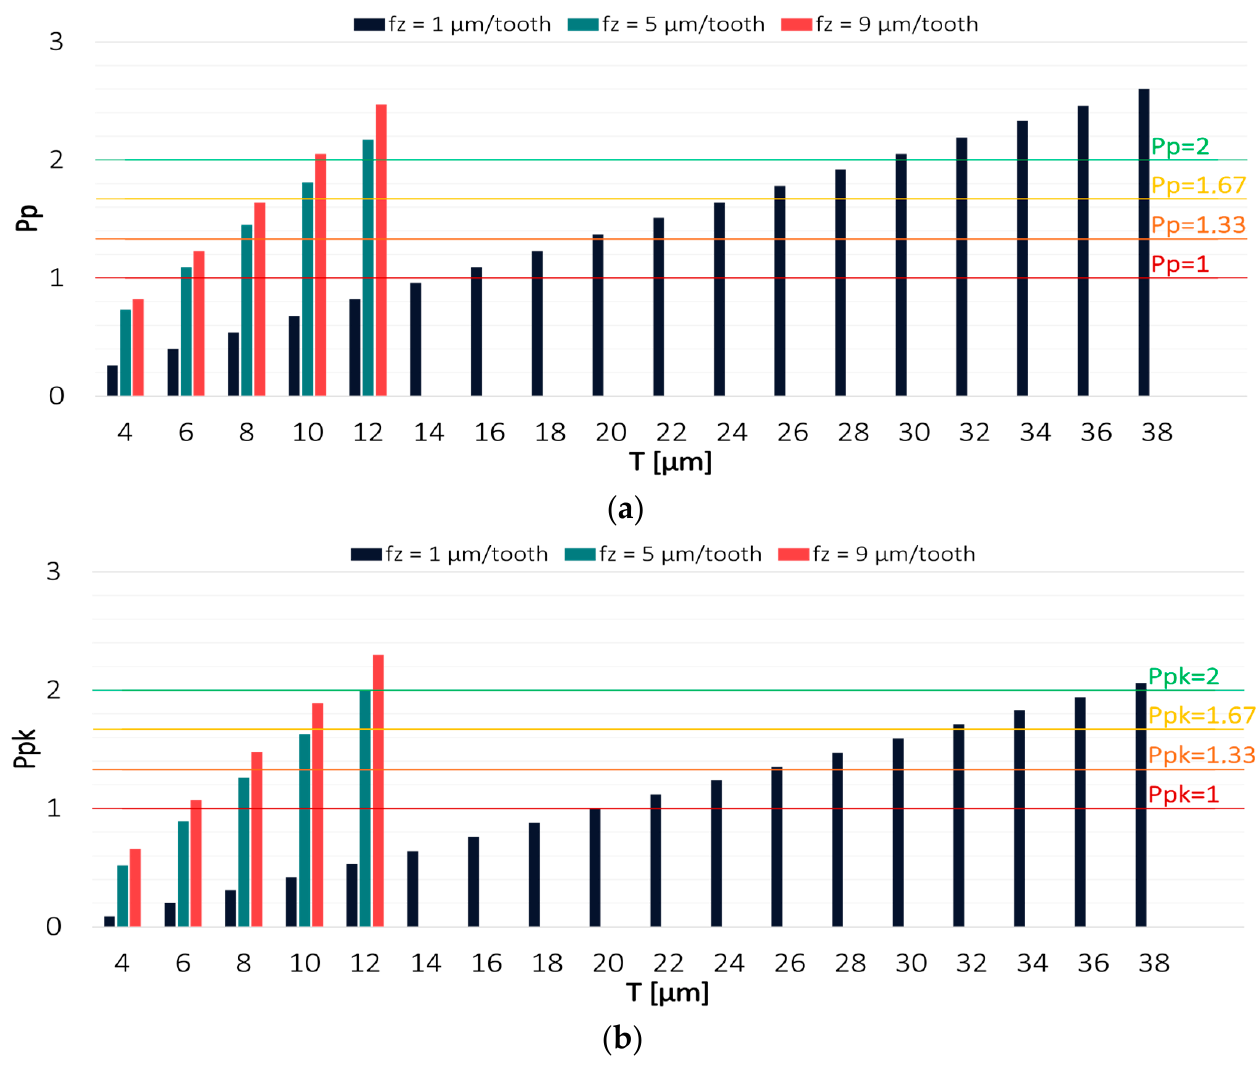
Figure 6. Values of ( a ) Pp and ( b ) Ppk for the results obtained in a milling process conducted with variable feed per tooth and TiAlN-coated tool.